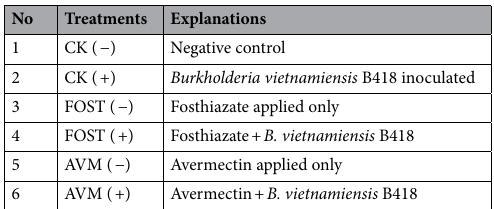
Table 3. Experimental treatments. Factor 1: ( +) with B. vietnamiensis B418 inoculation; ( −) without B. vietnamiensis B418 inoculation. Factor 2: Control (CK); Fosthiazate (FOST); Avermectin